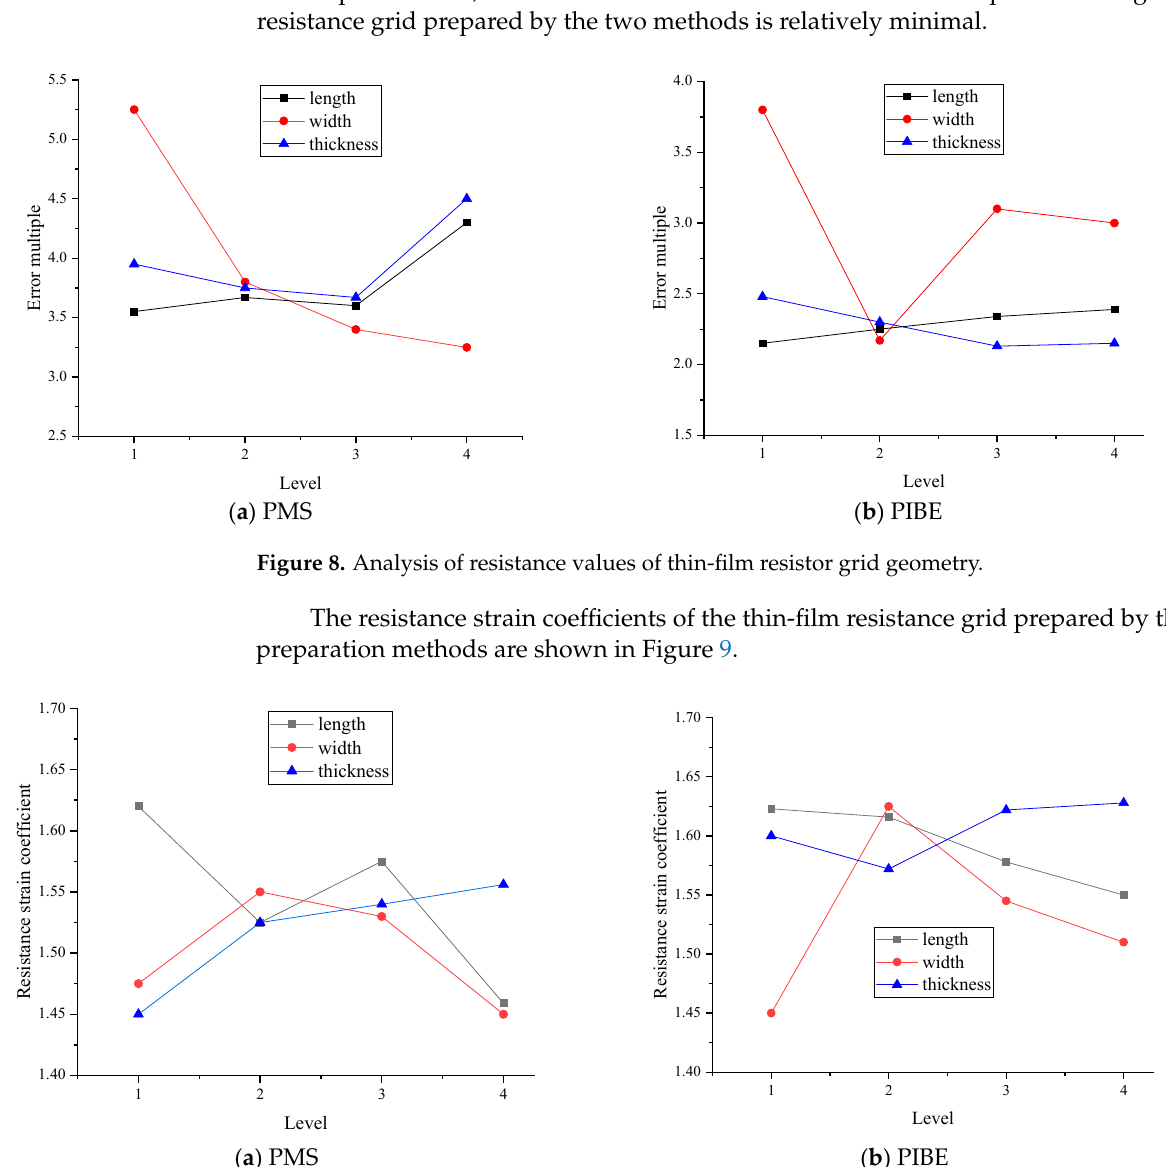
of the thin-film resistance grid by the two preparation methods. As show in Figure 8a,b, the width of the longitudinal grid has the highest impact on the resistance value of the thin-film resistance grid, and the resistance error generally decreases with the increase in the width; with the increase in the thickness, the resistance error first decreases and then increases, and it reaches the lowest when the thickness is 1000 nm. Relating to the length of the thin-film resistance grid, in Figure 8b, the curve of error fluctuates slightly multiple times up and down, and this shows a stable trend. The error multiple of the length of the resistance grid prepared by the two methods is relatively minimal.